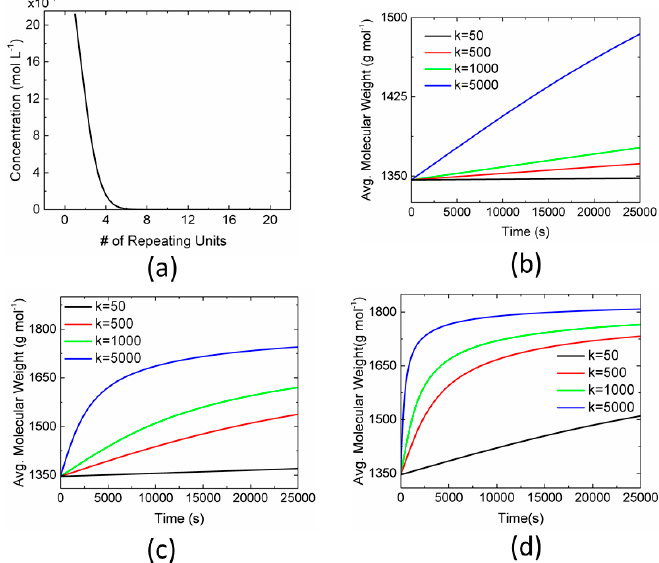
Figure 2. Change in average molecular weight of SBU oligomers as a function of time for different values of oligomerization rate constants. ( a ) Steady-state distribution of oligomers of SBUs at k = 500 and initial saturation ratio of 1. The transient evolution of average molecular weight for initial saturation ratios of ( b ) 0.2, ( c ) 0.5, and ( d ) 1.